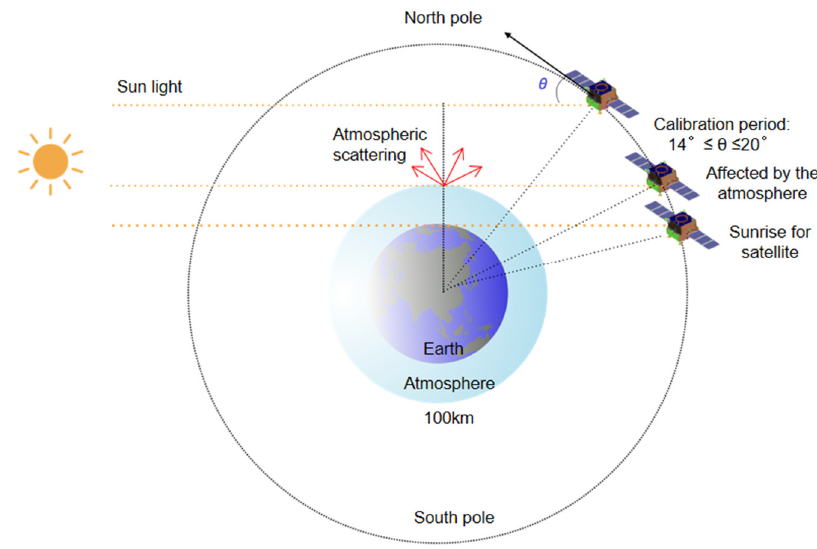
Figure 1. Schematic of Sun-based radiometric calibration period of SCS.